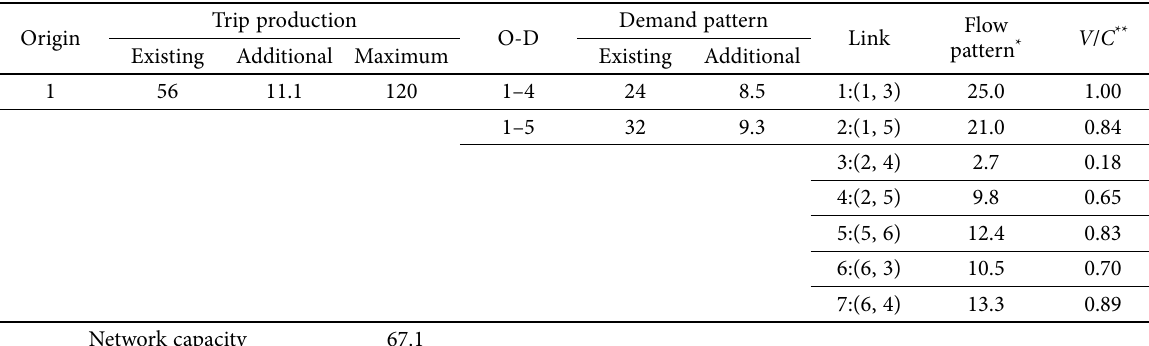
Table 3. Traffic flow pattern before the building of the transit